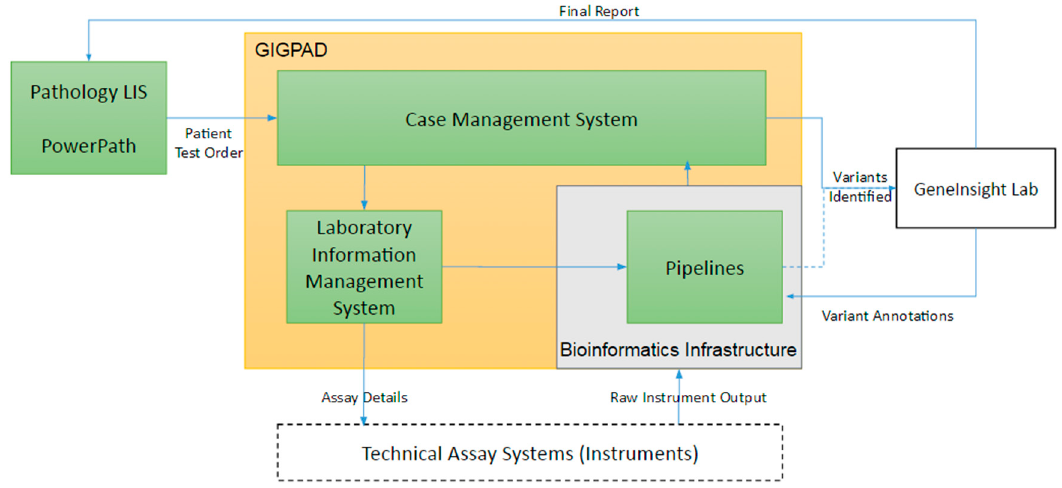
Figure 3. Infrastructure supporting the technical assay.